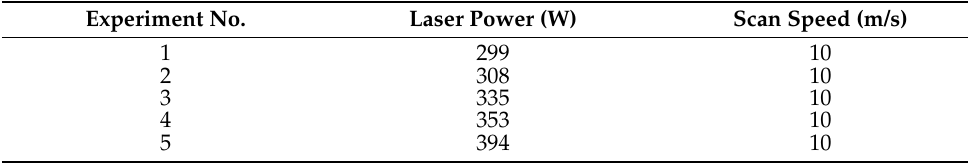
Table 1. Process conditions used in the laser annealing